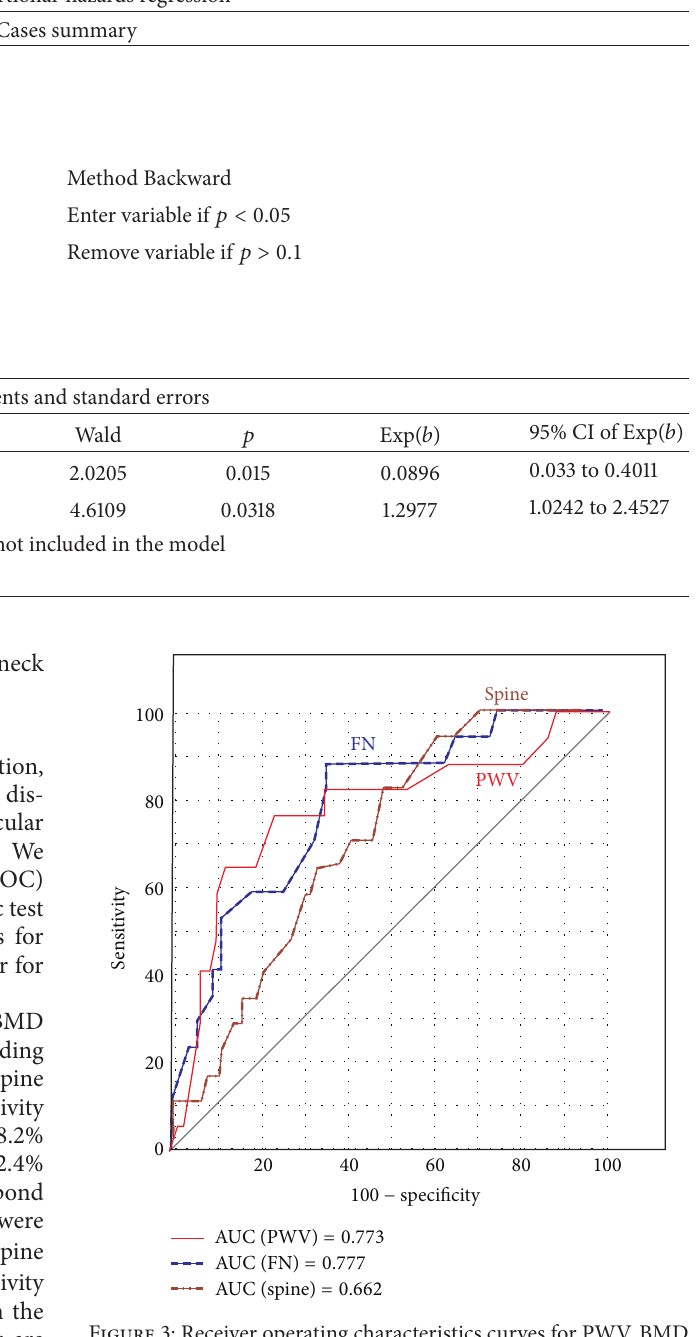
Figure 3: Receiver operating characteristics curves for PWV, BMD of femoral neck and lumbar spine as a prognostic marker for cardiovascular event. PWV: pulse wave velocity; FN: femur neck; AUC: area under the ROC curve